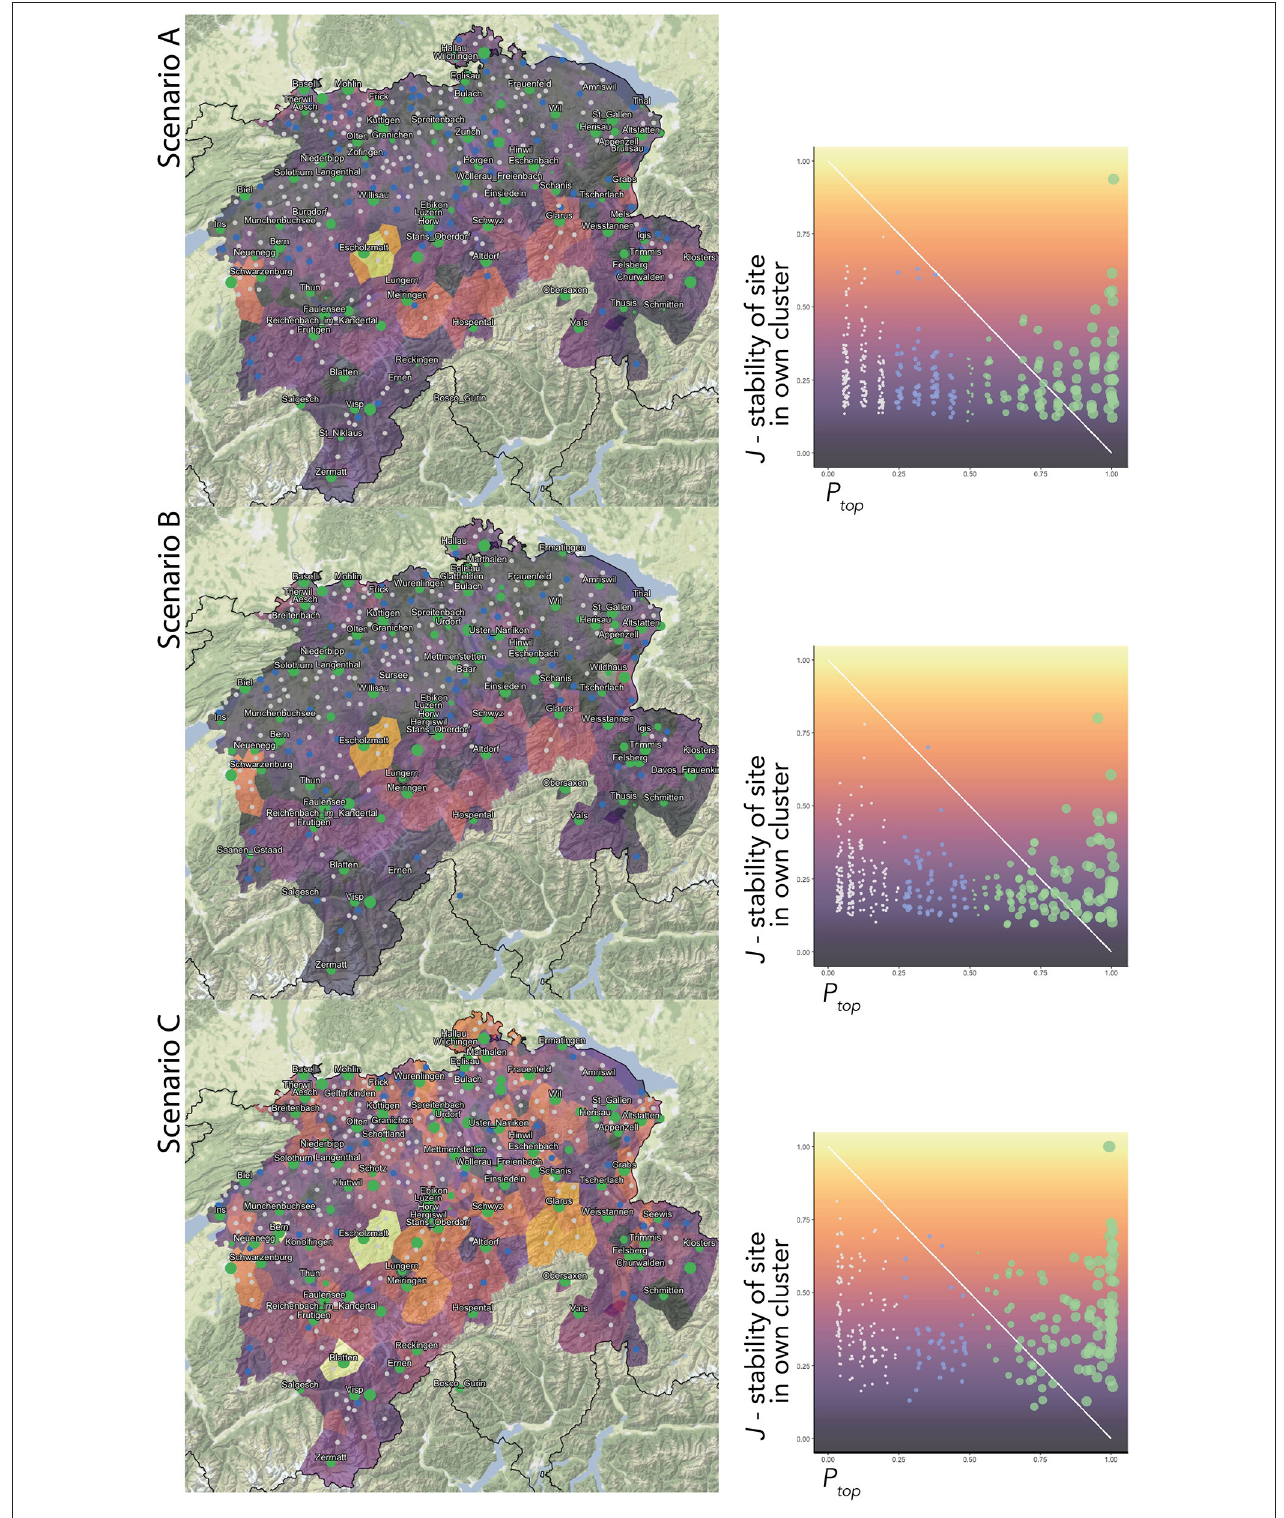
FIGURE 7 | Composite maps and graphs presenting the two candidacy factors deciding the ranking of an SDS survey site to become a candidate site for SDATS. The proportion of occasions a survey site was clustered together with the same others, J (stability of a site in its own cluster) is mapped between dark purple and yellow hues, where yellow means higher stability. The number of times (among the clustering solution on different subsets) a site has the most inhabitants in its own cluster is shown by P top . The best candidate sites score high in both P top and J . Such sites are presented as green circles on lighter polygons in the map.